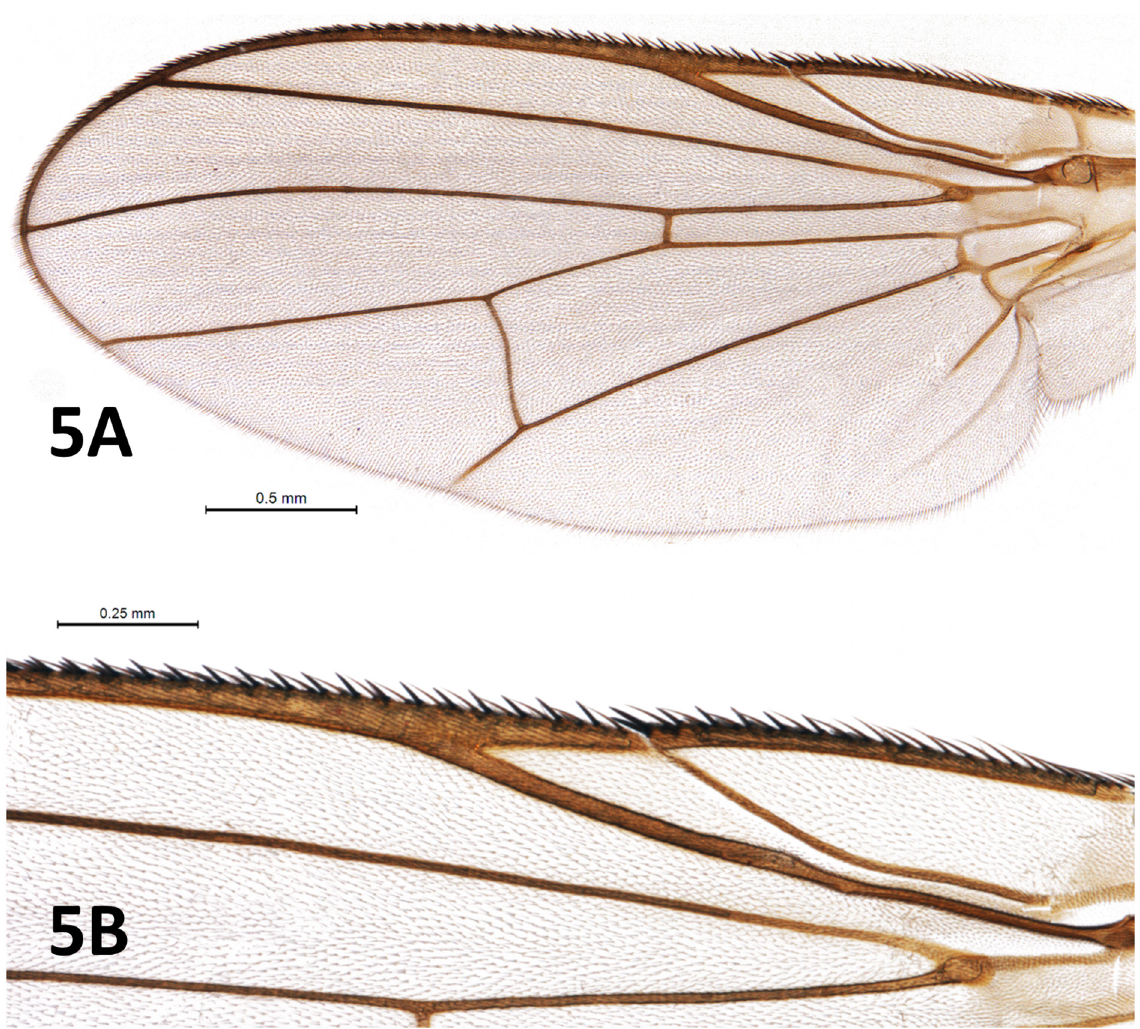
Fig. 5. Azelia cilipes (Haliday, 1838) ♀. A . Wing, ventral view. B . Detail of wing showing CS1‒3, ventral